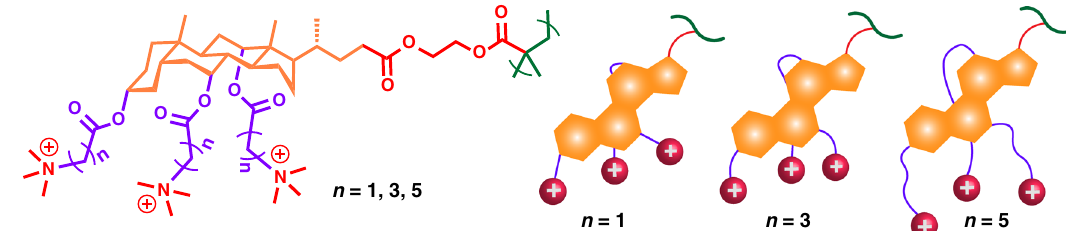
Fig. 5 Cholic acid-based cationic polymers with different spacers. Chemical structures of polymers and their illustration